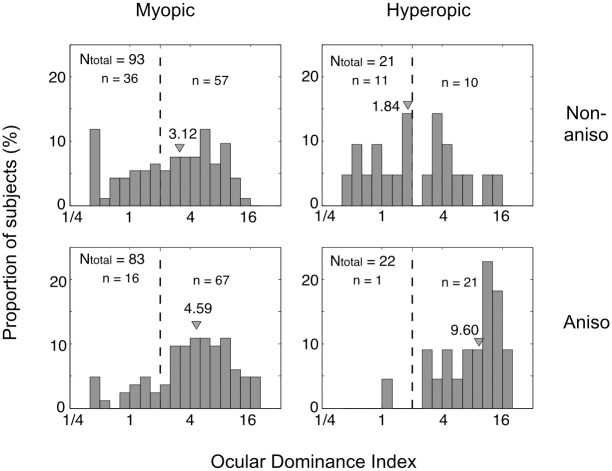
The distribution of ocular dominance index in myopic (left column) and hyperopic (right column) subjects.Top row: non-anisometropic subjects; bottom row: anisometropic subjects. Triangles represent median values.